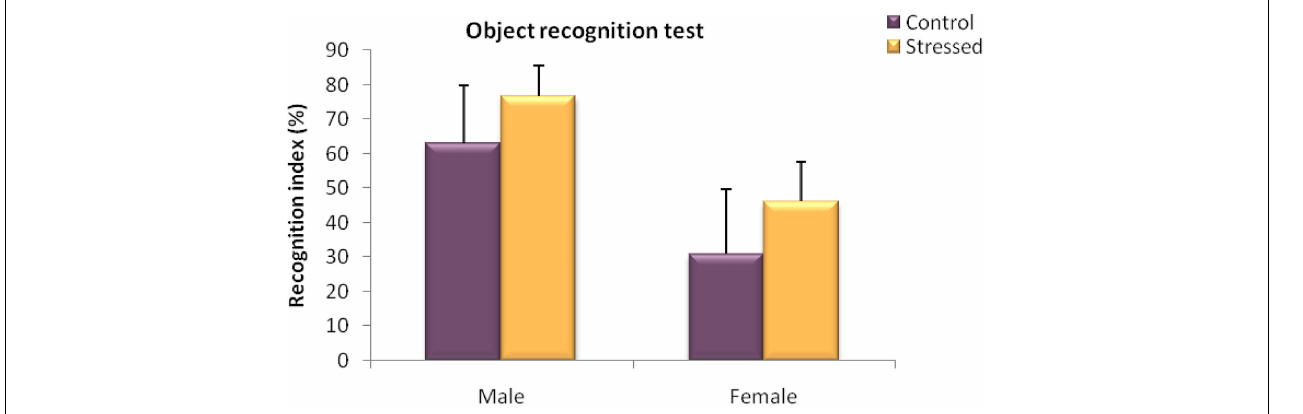
FIGURE 6 | Behavioral evaluation of recognition memory disorders in male rats in a Novel object recognition test (Recognition index%). Cold stress had no significant effect on the recognition performance assessed in an object recognition test in male and female rats. Each value represents the mean ± SEM; Effect of stress: ns p > 0.05 (ns: not significant) ( n =